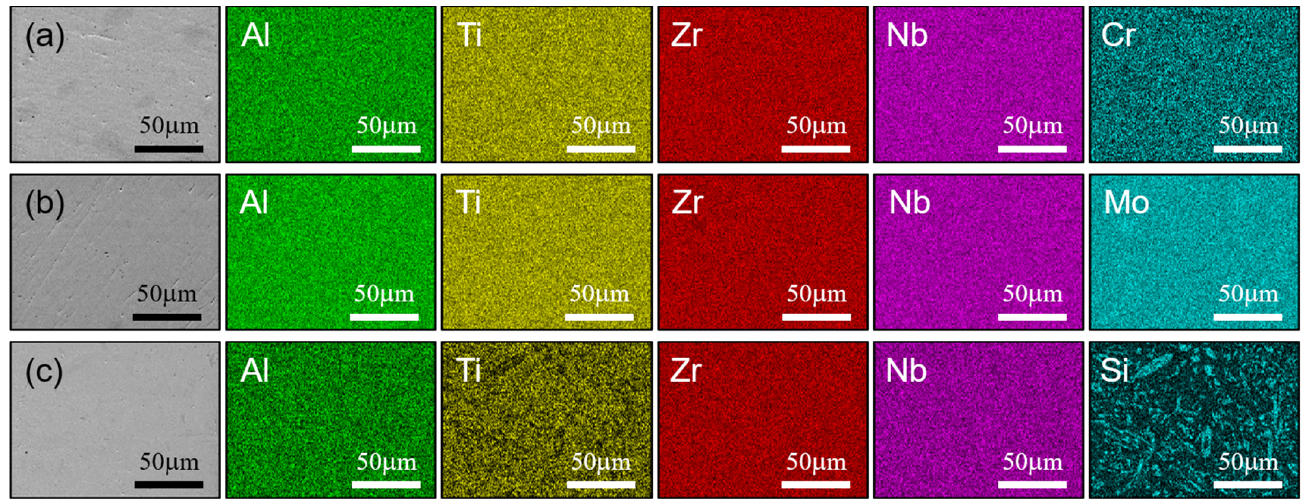
Figure 2. The EDS mappings of the Al 15 Zr 40 Ti 28 Nb 12 M 5 (Cr, Mo, Si) HEAs with secondary electron (SE2). ( a ) Cr 5 HEA, ( b ) Mo 5 HEA, and ( c ) Si 5 HEA.